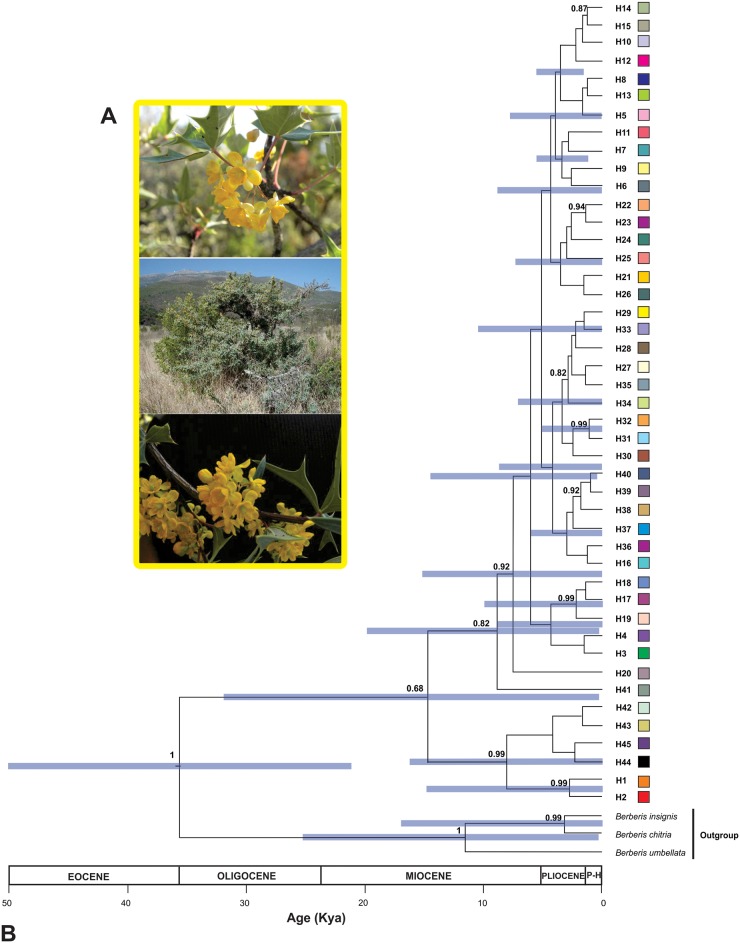
A) Flowers and habit of Berberis trifoliolata. B) Bayesian chronogram showing the time of divergence Agarito haplotypes. Colours of the squares correspond to those of Fig 1. The 95% credibility intervals are shown by purple bars.